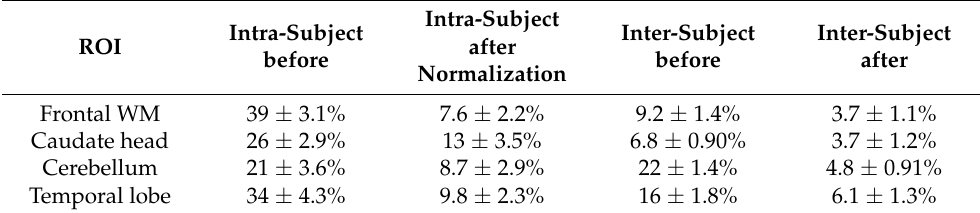
Table 2. ROI analysis of the CV maps in Figure